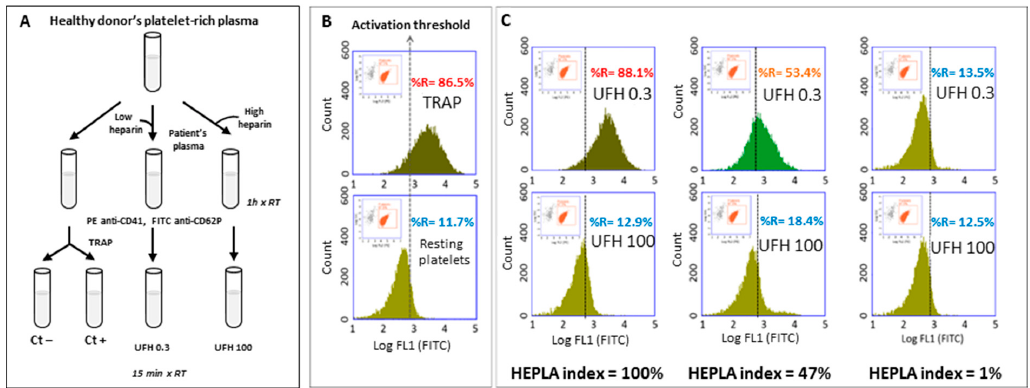
Figure 3. Detection of heparin-dependent platelet-activating antibodies with FCA. ( A ) Schematic procedure of the FCA. ( B ) The first gate delineates the platelets ((log SSC + log FL2-PE (CD41+ events)) and the second gate is applied to analyze the activated platelets (log FL1-FITC). Determination of the activation threshold: upper panel, TRAP-activated platelets (Ctl+); lower panel, resting platelets (Ctl-), the cursor indicating the activation threshold is placed at the intersection of the FL1 histograms of the positive control (Ctl+) and the negative control (Ctl-). “%R” represents the percentage of CD-62P positive events as an index of platelet activation. This set-up allows determining percentage of the activated platelets (to the right of the activation threshold) under different conditions. ( C ) Incubations with patients’ plasma and one platelet donor: typical results with low (0.3 IU/mL heparin) and high (100 IU/mL heparin) concentrations of heparin (top and bottom rows, respectively). Left panels: platelets activated with a highly HIT-positive plasma (optical density, OD = 2.5); middle panels: platelets activated with a weakly HIT-positive plasma (OD = 1.3); right panels: platelets incubated with a non-HIT plasma. The HEPLA index is calculated as follows: HEPLA index = (% H 0.3 − % H 100) / (% TRAP Ctl+ − % PBS Ctl-) × 100. FCA: flow cytometric assay, SSC: sideways scatter, PE: